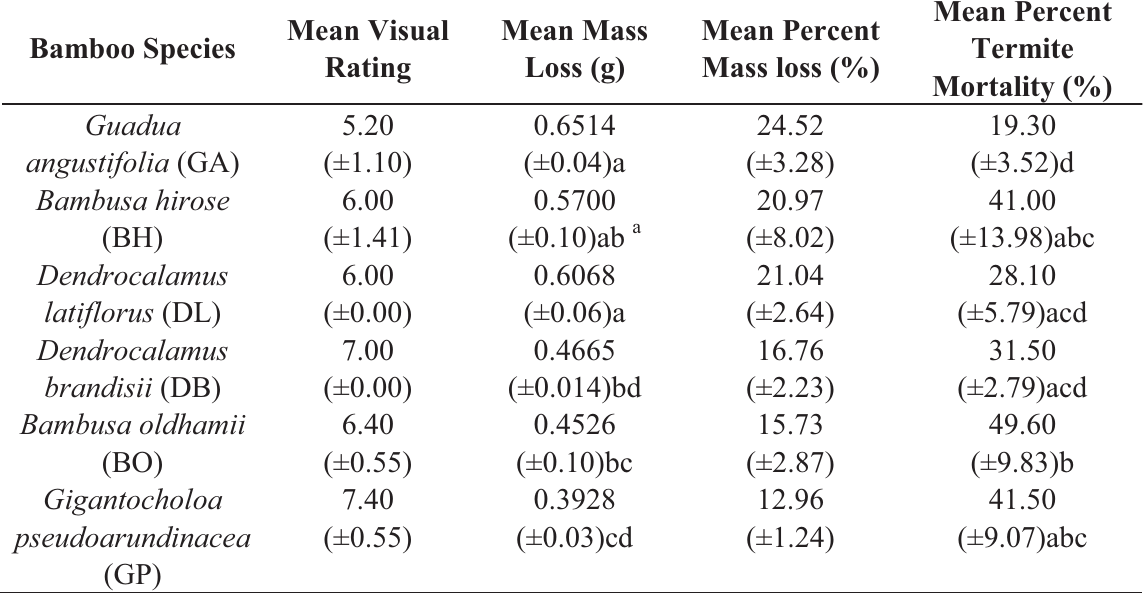
Table 2. Summary of results for C. gestroi from no-choice test. ( a Values in parentheses are standard deviations; means within a column followed by the same letter are not significant at the 5% level (one way ANOVA, Tukey’s HSD— SAS 9.2), Rating: 10 (sound), 9.5 (trace, surface nibbles permitted), 9 (slight attack up to 3% of cross sectional area affected), 8 (moderate attack, 3 – 10% of cross sectional area affected), 7 (moderate/severe attack, penetration, 10 – 30% of cross sectional area affected), 6 (severe attack, 30 – 50% of cross sectional area affected), 4 (very severe attack, 50 – 70% of cross sectional area affected) or 0 (failure)).